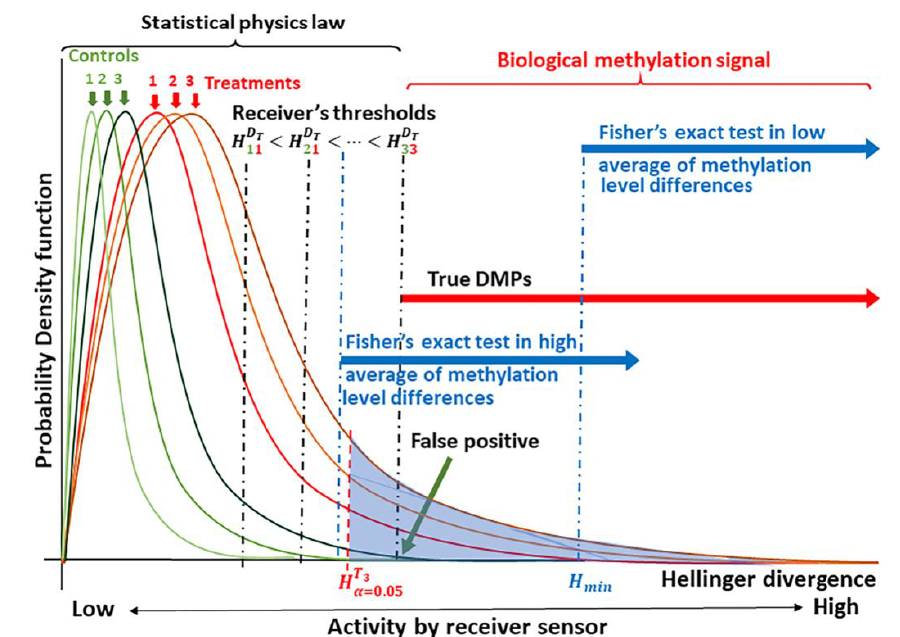
Figure 1. Schematic of the theoretical principle underlying signal detection applied to methylation analysis. Knowledge of the probability distribution for the methylation signal, here given as the Hellinger Divergence ( H ) of methylation levels, permits the identification of “true” differentially methylated positions (DMPs) [21,22]. Critical values are used to discriminate between a biological methylation signal and the molecular thermal noise generated by biochemical processes and conforming to laws of statistical physics [25–27,40]. Next, signal detection is designed to identify an optimal cuto ff value, (here denoted as H D T ) to discriminate the methylation signal induced by the treatment from the natural background variation [5,33]. Empirical comparisons allow the placement of Fisher’s exact test for the discrimination of DMPs.